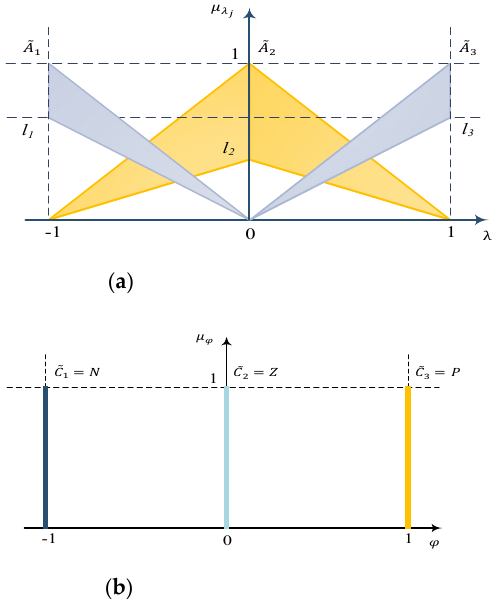
Figure 7. Schematic of ( a ) antecedent IT2-FSs ( b ) singleton membership functions. Therefore, δ j consists of a design parameter that should be regulated for all inputs, λ j In which 𝜑 (cid:3045)(cid:3010)(cid:3021)(cid:2870) and 𝜑 (cid:3039)(cid:3010)(cid:3021)(cid:2870) signify endpoints of the type of reduced set which is demonstrated in Reference [36], and using iterative algorithms is common for obtaining the switching points (L, R) in these equations.